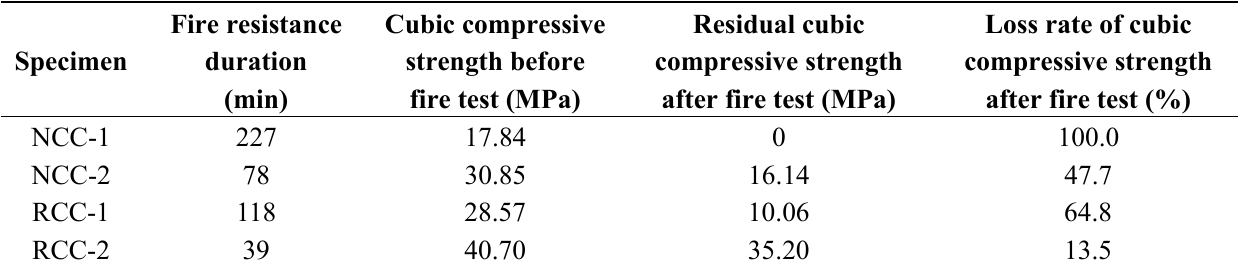
Table 4 listed the residual cubic compressive strength and its loss rate n loss after fire tests. Table 4. The cubic compressive strength and its loss rate after fire